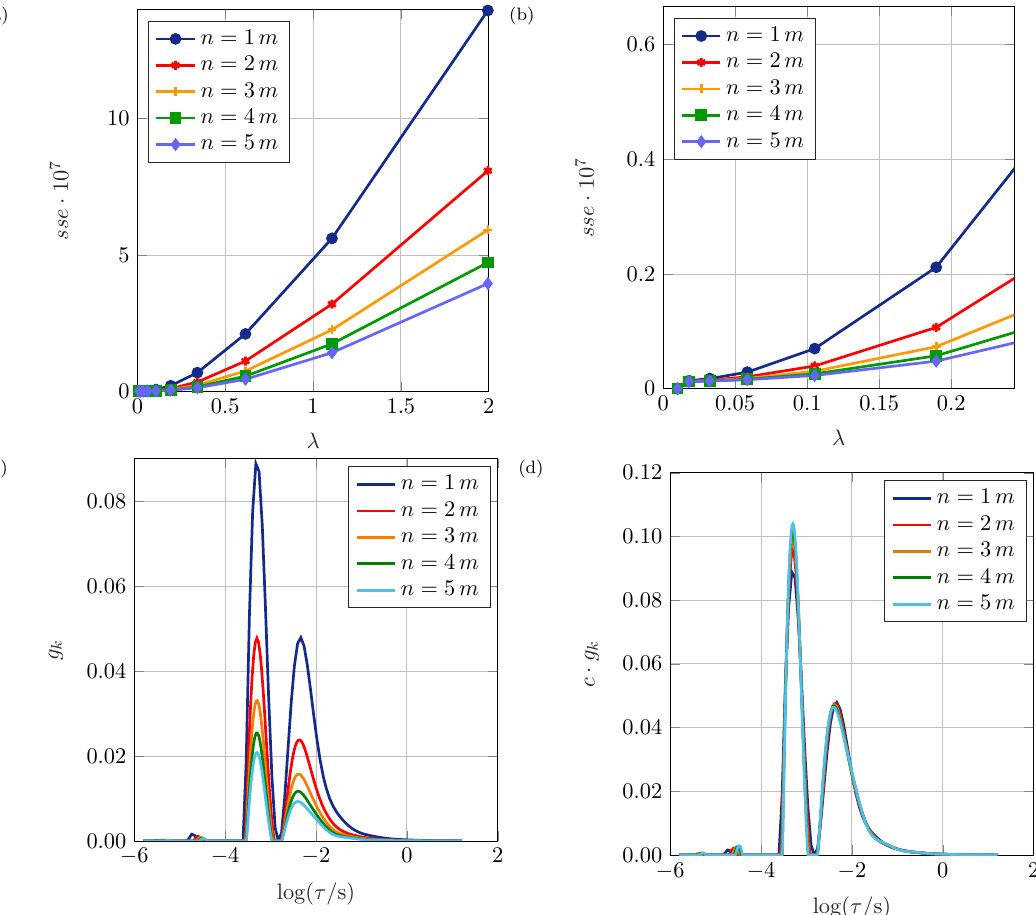
Figure 4. The sum of squared errors ( sse ) of the reconstructed spectra for differing n and a variation of λ between 0.01. and 2 ( a ) and a magnified detail for small λ ( b ), g k for λ = 0.1 and varied n ( c ) and c g k ( d ), where c is the multiple of m for every line respectively. ·